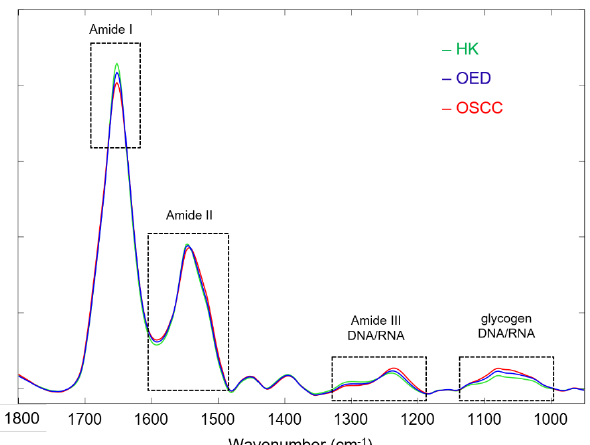
Figure 3. Three class-average spectra after general preprocessing for HK (green), OED (blue), and OSCC (red) samples, with visible spectral differences highlighted in dashed boxes.